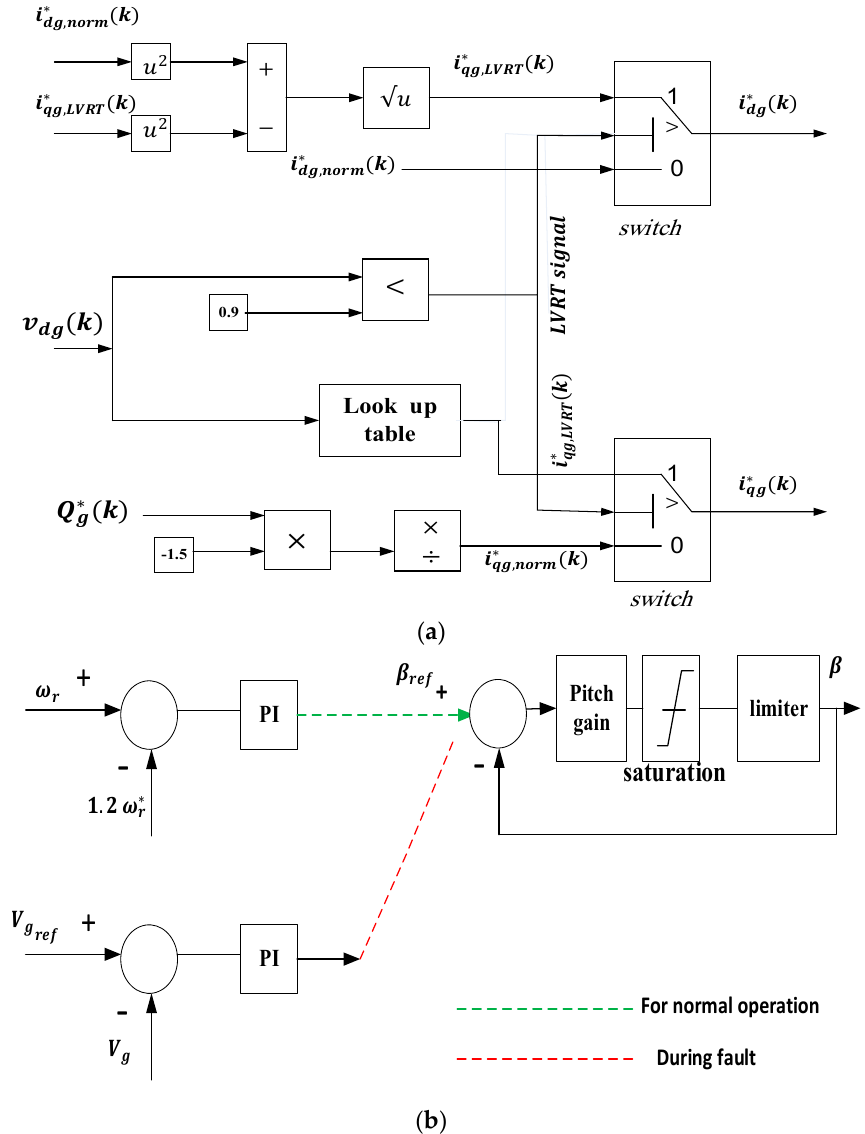
Figure 10. Coordinated low voltage-ride through (LVRT) algorithm: ( a ) Control structure of grid side converter; ( b ) Pitch control structure diagram.